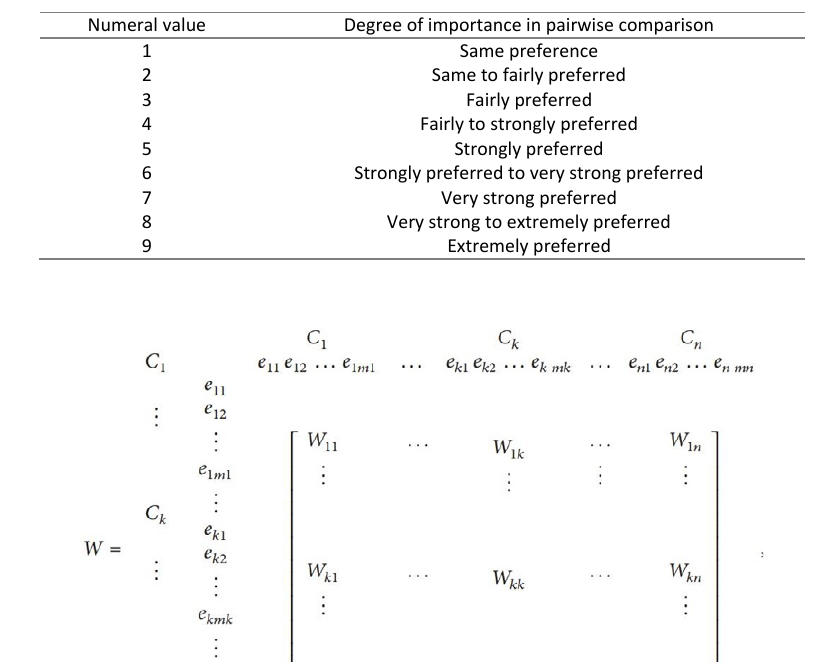
Table 3: Numeral values for items comparison